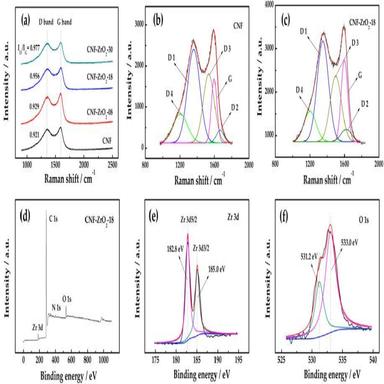
Raman spectra of CNF and ZrO2/CNF (a), XPS full spectrum of CNFeZrO2-18 (b), corresponding high-resolution XPS spectra for Zr 3d (c) and O 1s (d).